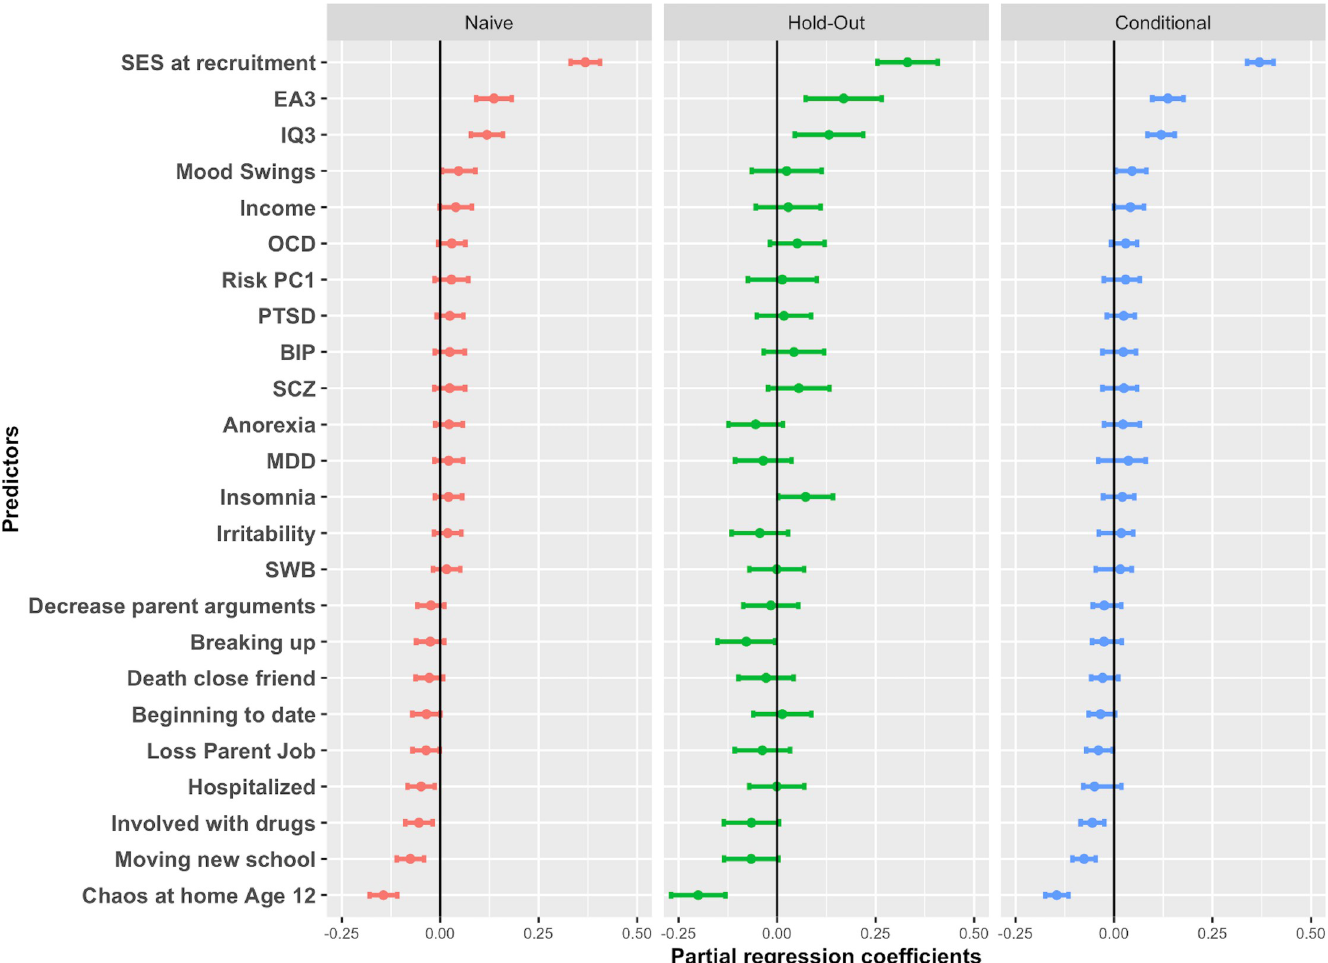
Fig 2. Relative contributions of model selected variables for the G+E model in the prediction of educational achievement. Figure shows partial regression coefficients, and 95% CIs around estimates. Naive = partial regression coefficients from multiple regression of selected variables in Training set; Hold-out = partial regression coefficients of selected variables in the hold-out set; Conditional = partial regression coefficients of training set for selected variables estimated with a conditional probability from a truncated distribution (see methods section). Note. ASD = Autism Spectrum Disorder, ADHD = Attention-Deficit Hyperactivity Disorder, BIP = Bipolar Disorder, EA3 = Educational Attainment, IQ3 = Intelligence, MDD = Major Depressive Disorder, SWB = Subjective Well-Being, OCD = Obsessive Compulsive Disorder, PTSD = Post-Traumatic Stress Disorder, Risk PC1 = First Principal Component of Risky behaviors, SCZ = Schizophrenia.